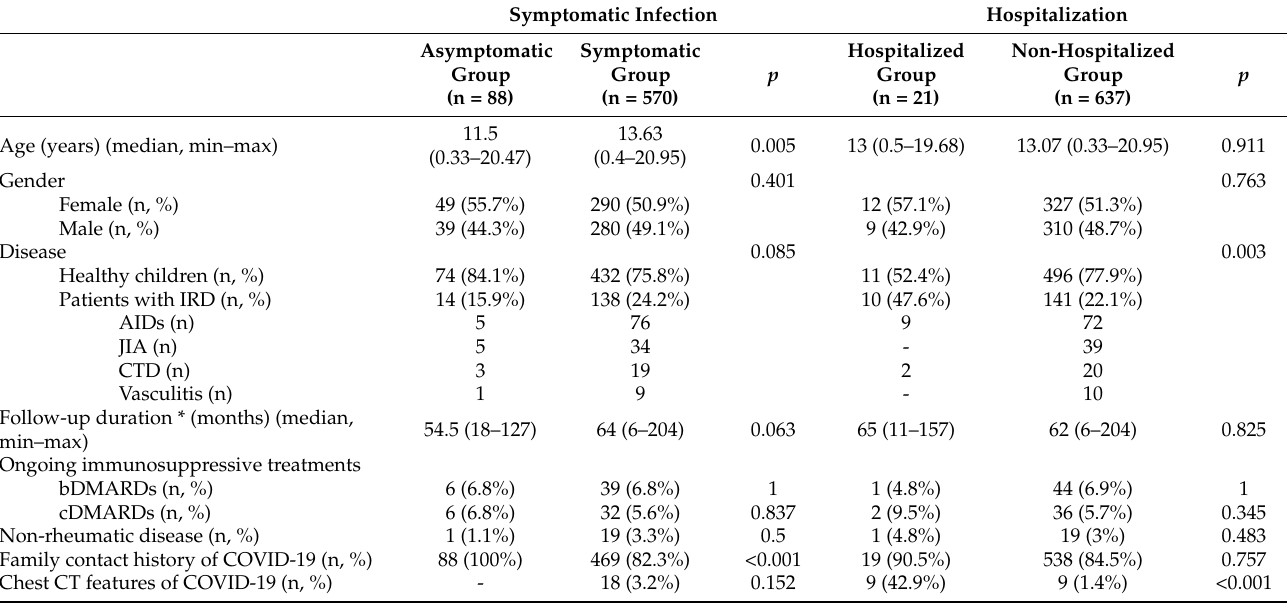
Table 2. Demographic and underlying disease-related data comparisons between symptomatic and asymptomatic, and hospitalized and not hospitalized